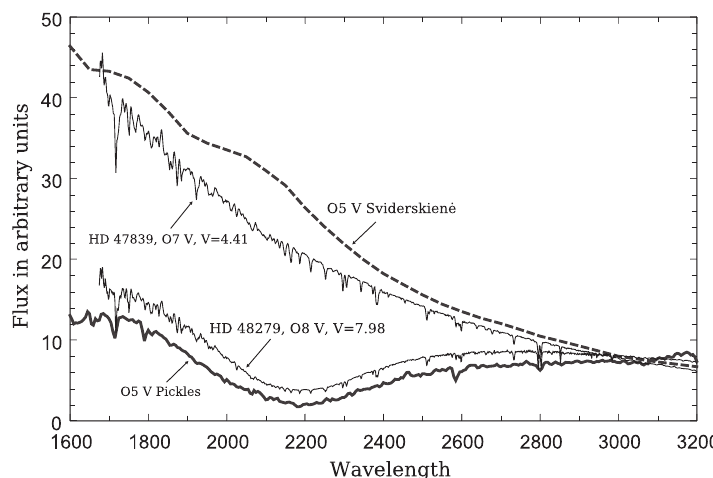
Fig. 6. O stars: observational data and semi-empirical atlases by Sviderskiene (1988) and Pickles (1998). See explanation in the text.